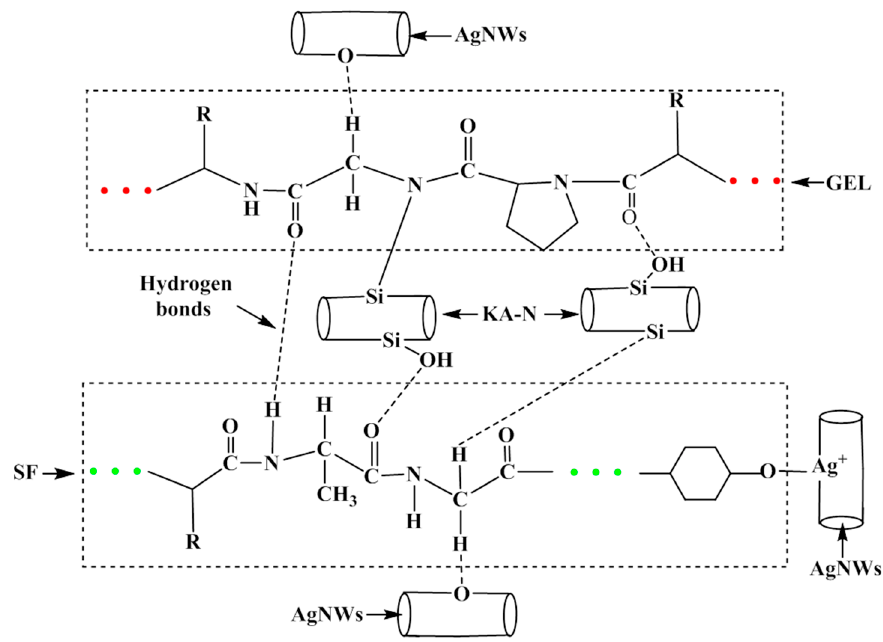
Figure 7. Schematic diagram of the proposed interactions between SF, Gel, KA-N, and AgNWS.